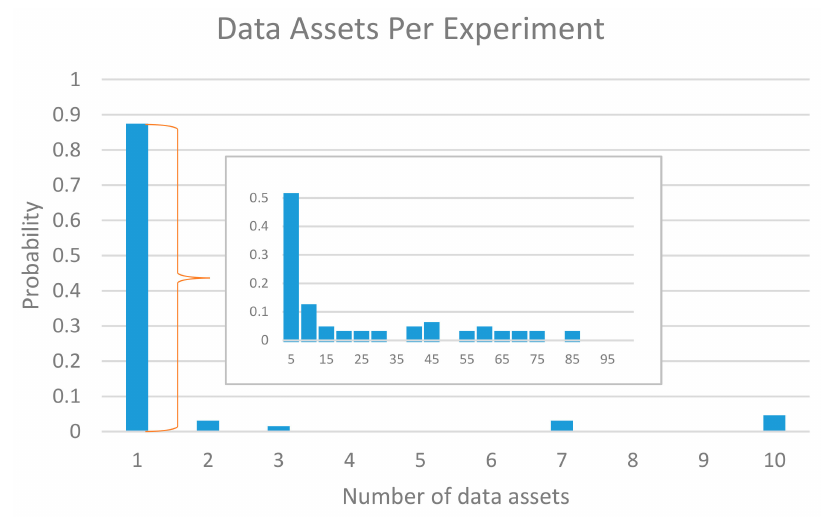
Figure 8. Probability distribution of the number of data assets created by the